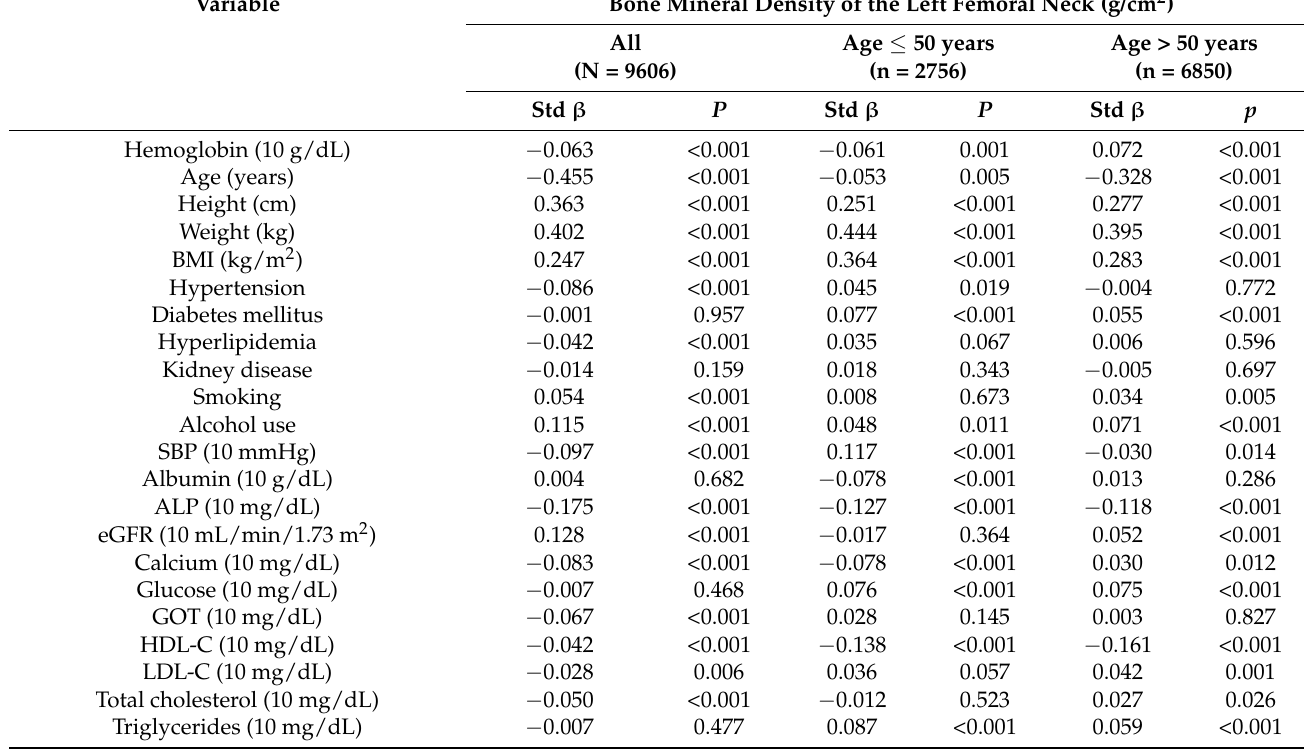
Table 5. Simple linear regression analysis of factors associated with bone mineral density of the left femoral neck in all female patients and those stratified by